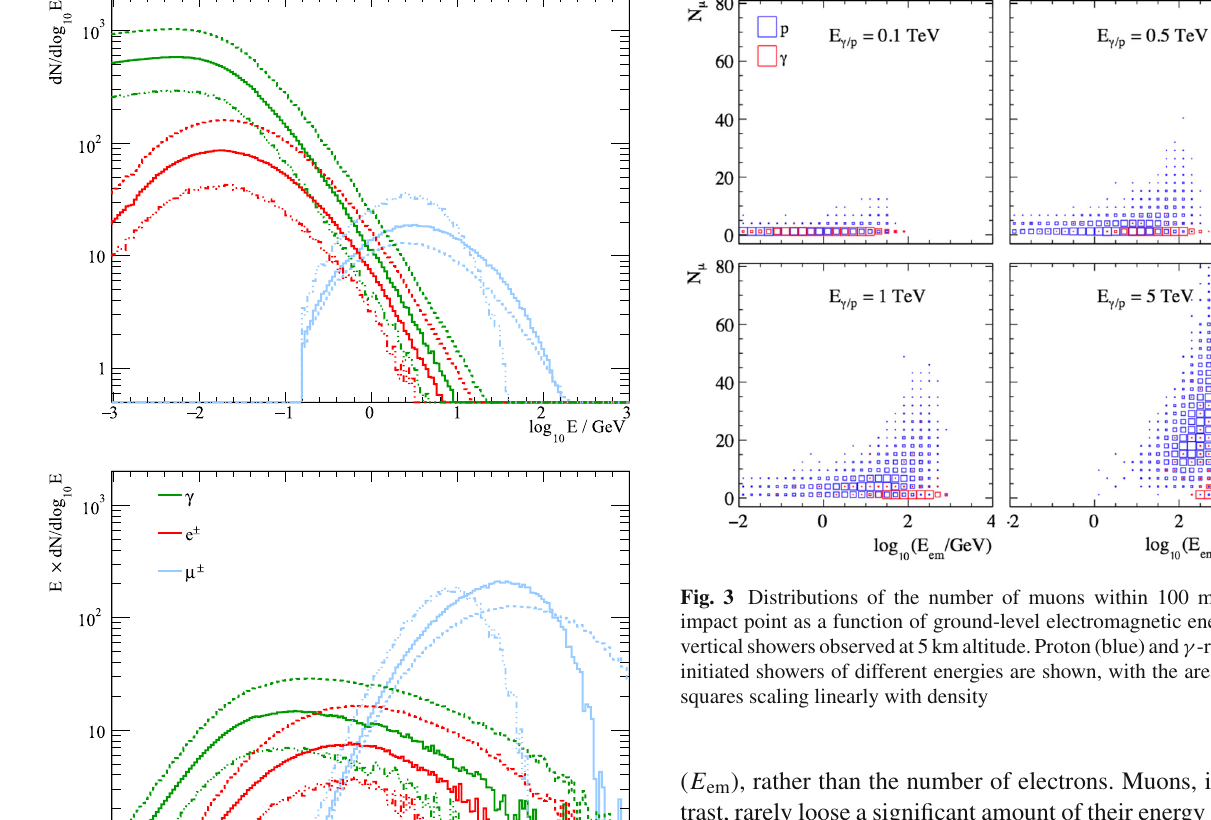
( E em ), rather than the number of electrons. Muons, in